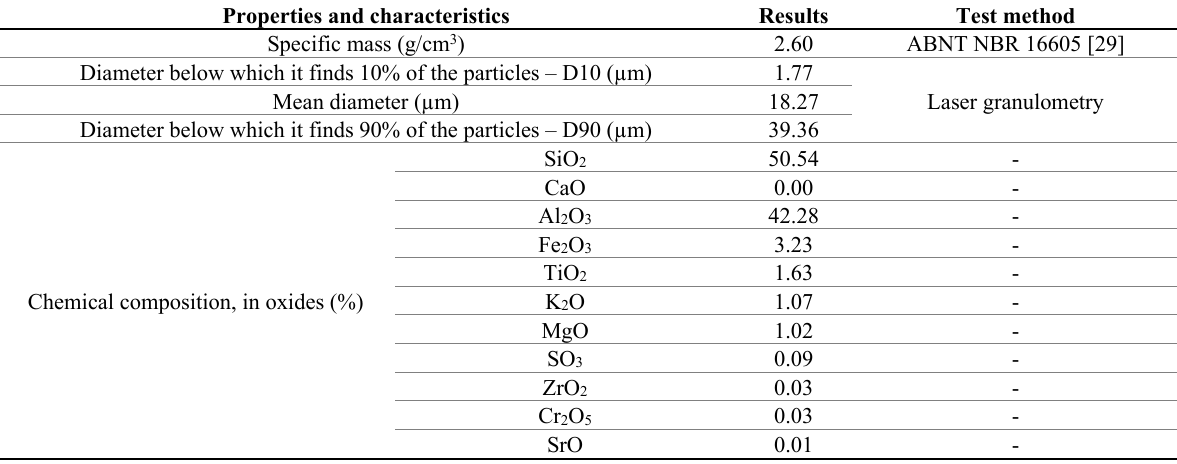
Table 2. Physical and chemical properties of the metakaolin.